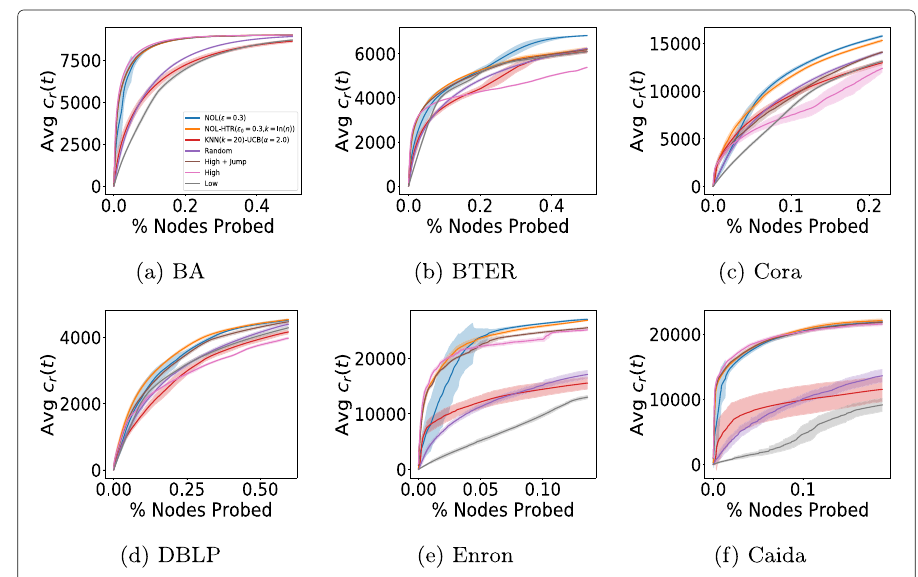
Fig. 3 Cumulative reward, c r ( t ) , averaged over experiments on multiple independent samples of both synthetic (BA, BTER) and real world networks. In the BA network a , where probing the highest degree node is optimal, NOL “learns the heuristic”. NOL outperforms the baseline methods in BTER networks b , where the combination of heavy tailed degree distribution and relatively high clustering and modularity allows for discrimination. In some real networks ( c , d , e ), NOL either outperforms or closely tracks the best baseline, while in a real network with properties similar to a BA model f NOL is outperformed by the high degree baseline